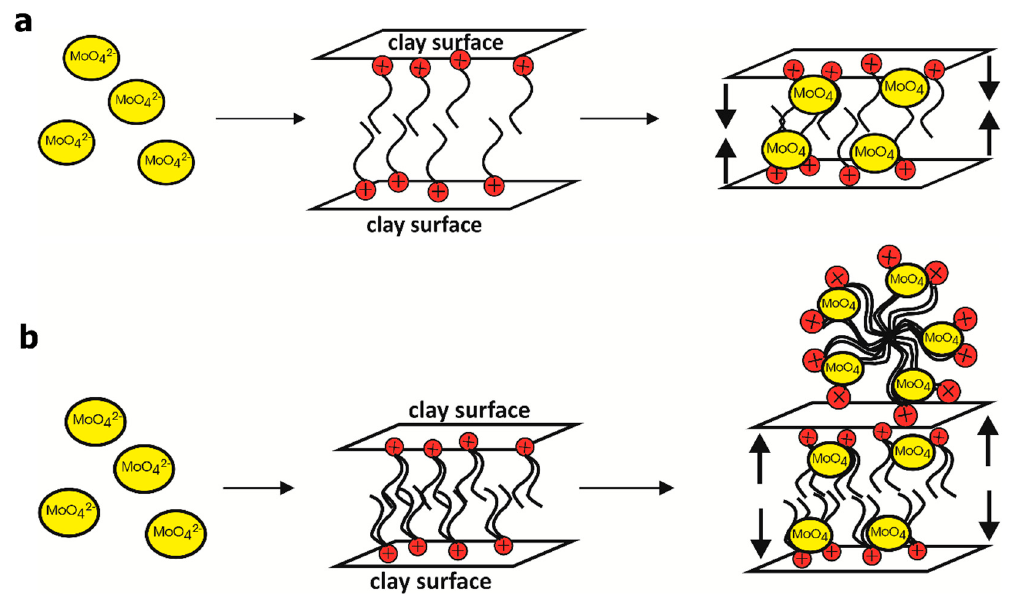
Figure 7. Mechanisms of immobilization of Mo(VI) onto: ( a ) DDTMA-M, ( b ) DDDDMA-M.